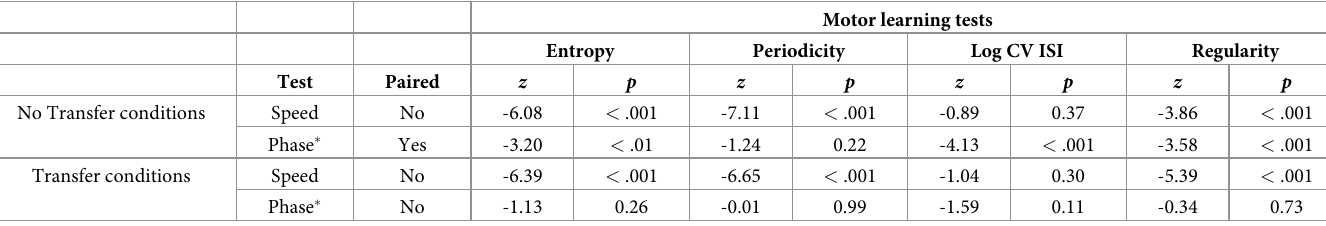
Fig 9B. Correlations between periodicity and skill levels are shown on S4A Fig, and correla- tions between regularity and skill levels are shown on S4B Fig.